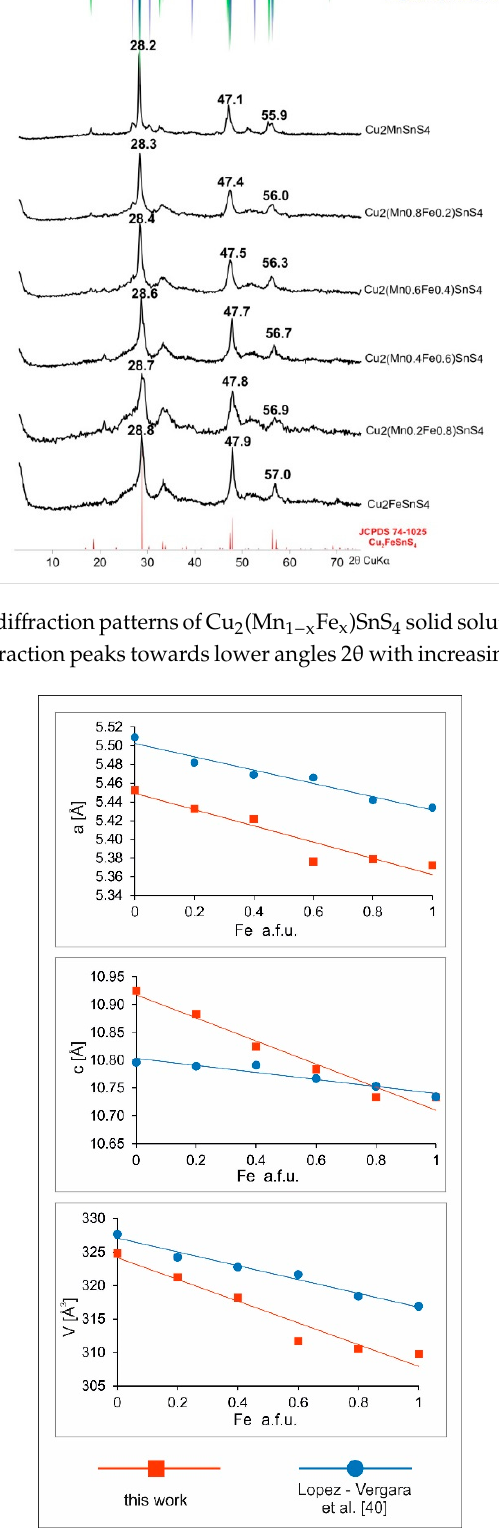
Figure 11. Linear changes of unit cell parameters in the CMTS-CFTS series as compared to similar results obtained by Lopez–Vergara et al. [40].